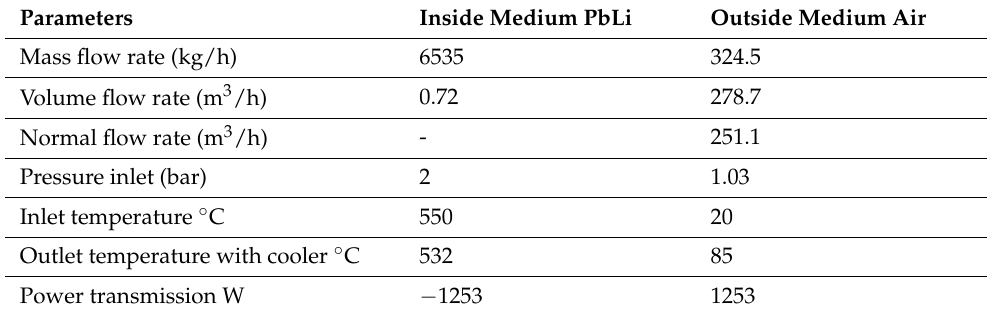
Figure 6. Principle of conductive level detection. Table 3. Working parameters of heat exchanger